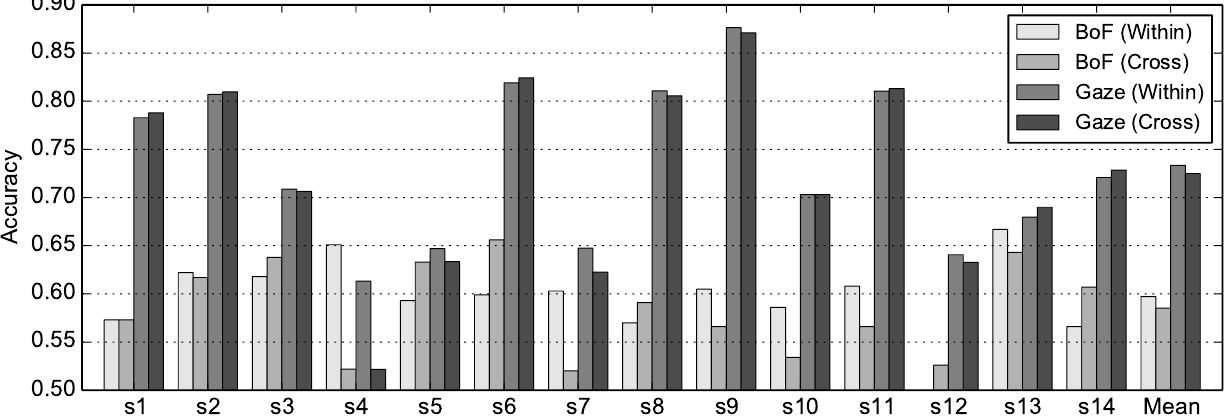
Figure 4 . Cross-subject training. The within-subject condition corresponds to the leave-one-out training and testing for each participant. In the cross-subject condition, the classifier is trained for each person using the data from the other participants. Each graph corresponds to a participant ( s 1 to s 14 ), and the rightmost graphs show the mean accuracy from among all the participants.